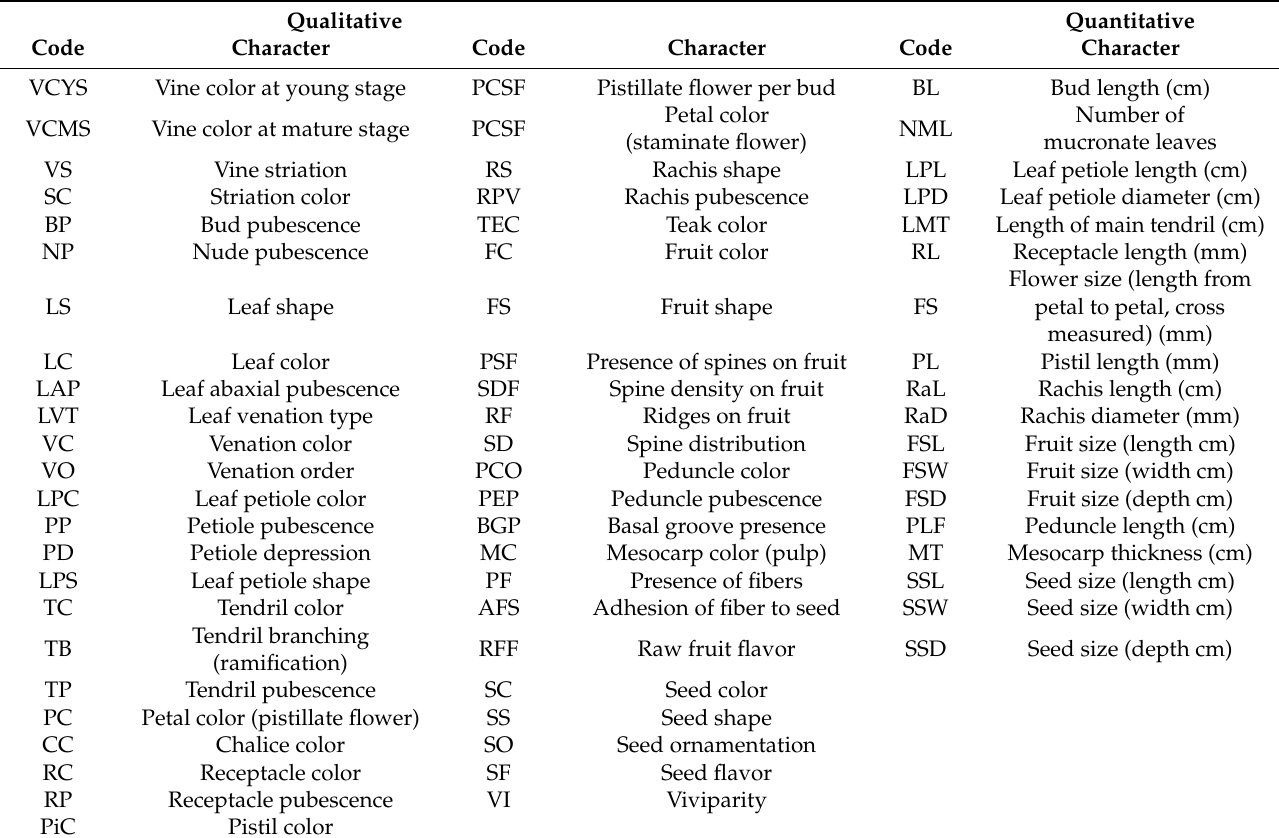
Table 4. Quantitative characteristics of evaluation, referring to distinction, uniformity, and stability (DUS) of the chayote plant ( Sechium edule ) variants according to